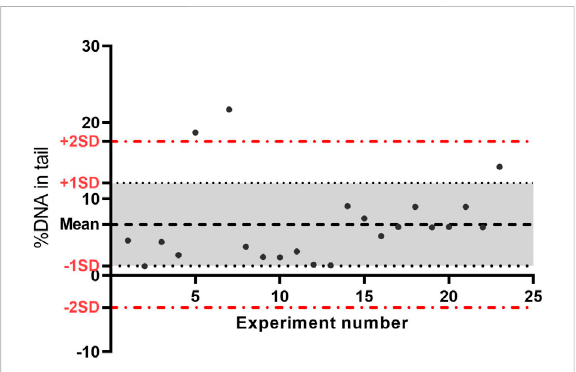
FIGURE 3 Data quality control chart of negative controls (no enzyme) from 22 experiments performed over time on A549 cells. The central line represents the average of all negative control data, the upper line (red) is for the upper control limit (+2SD), and the lower line (red) is for the lower control limit ( − 2 SD). The lines are determined from the laboratory historic data. By comparing current data to these lines, we can draw conclusions about whether the negative control is acceptable; if the value is outside theupper line,thenegative control is not acceptable. SD,standard